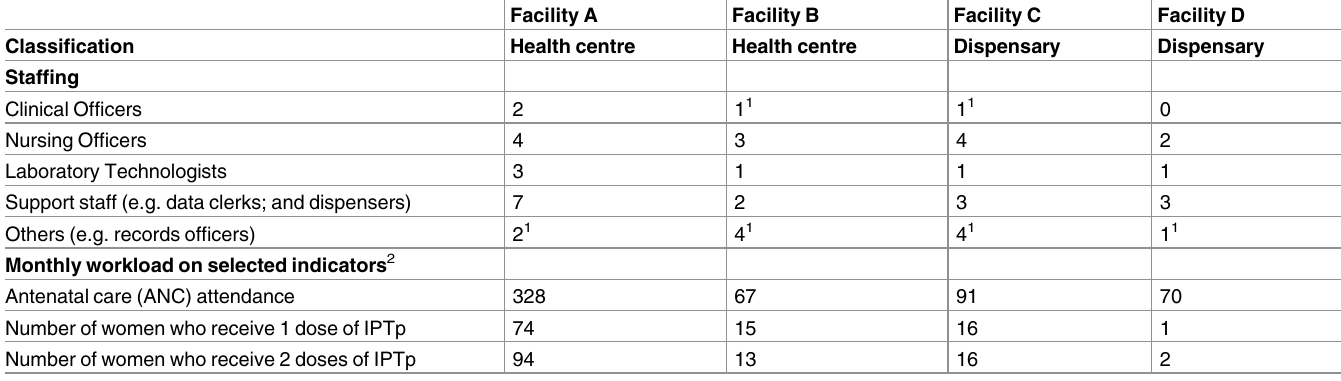
Table 1. Facility